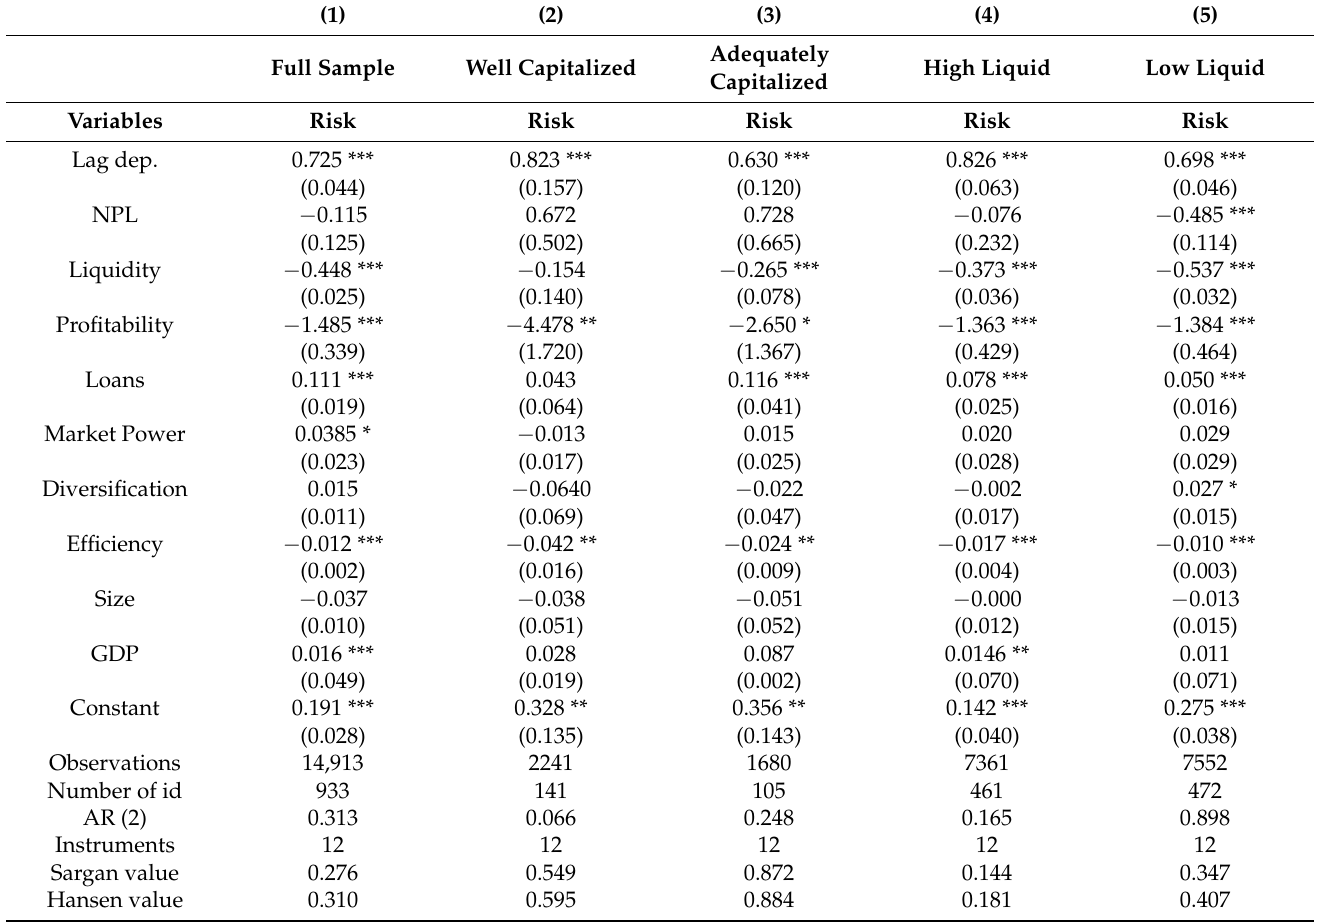
Table 5 used a two-step GMM method to measure the impact of macroeconomic fluctuation on banks’ capital buffer (ratio of risk-weighted assets to total assets) adjustment for the full sample, well, adequately, and high- and low-liquid banks. If the overall risk-based capital ratio (tier I + II/total risk-weighted assets ratio) of banks is 10% or above it is well-capitalized, if the ratio is between 8 to 10% it is considered an adequately capitalized bank. Based on their median value, commercial banks are classified as highly liquid or low-liquid banks. Banks with a higher ratio of liquid assets to deposits and short-term funding than the median are treated as highly liquid banks and low-liquid banks otherwise. Robust standard errors are reported in parentheses. ***, **, and * represent statistical significance at 1, 5, and 10%,